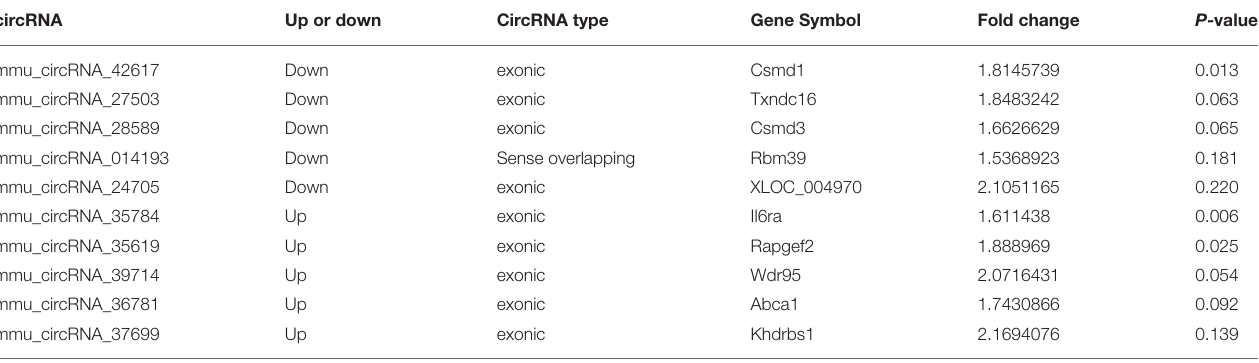
TABLE 2 | KEGG pathway analysis. Term Gene MAPK signaling